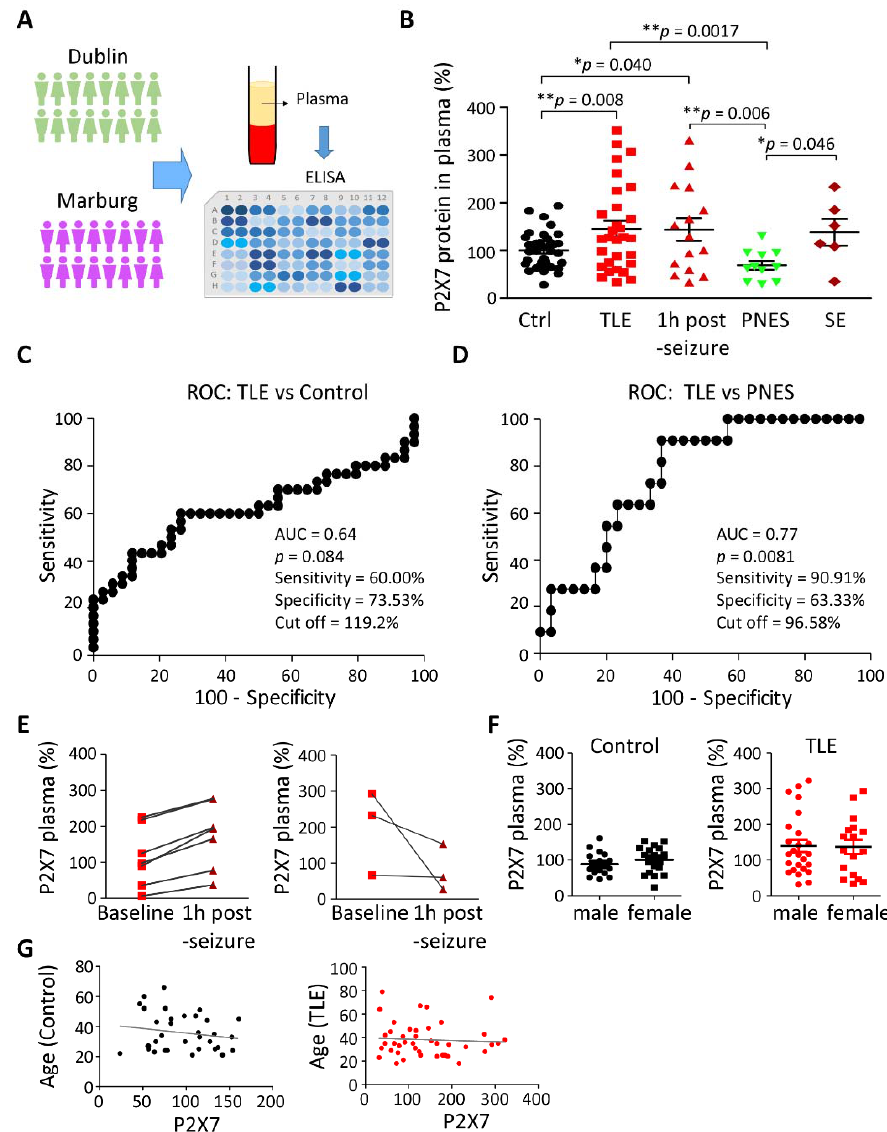
Figure 1. Increased P2X7R protein levels in plasma of patients with TLE. ( A ) Patients were recruited from two hospitals: Marburg Hospital (Germany) and Beaumont Hospital (Ireland), and plasma samples were analyzed via P2X7R-detecting ELISA. ( B ) Bar chart showing P2X7R protein levels in plasma from temporal lobe epilepsy (TLE) patients (N = 30) in baseline conditions and 1 h post ‐ seizure (N = 15) are higher when compared with healthy controls (Ctrl) (N = 34) and patients with psychogenic non ‐ epileptic seizures (PNES) (N = 11). In addition, P2X7R protein levels were also higher in patients suffering from an episode of status epilepticus (SE) (N = 6) when compared with PNES patients. ANOVA with post ‐ hoc Fisher correction. Data are given as percentage to control. ( C ) ROC curve analysis shows P2X7R plasma levels have a moderate sensitivity (60%) and good specificity (74%) for discriminating between healthy controls and TLE patients with an AUC of 0.64 at a cut ‐ off of 119.2%. ( D ) ROC curve analysis demonstrating a good sensitivity (90%) and specificity (63%) for discriminating between TLE patients and patients with PNES with an AUC of 0.77 at a cut ‐ off of 96.58%. ( E ) Dot plot showing P2X7R plasma levels in the same patients at baseline and 1 h post ‐ seizure. Out of 10 patients, 7 showed increased P2X7R in plasma and 3 lower P2X7R plasma levels 1 h post ‐ seizures when compared with the corresponding baseline levels. ( F , G ) No correlation of P2X7R plasma levels according to sex (F) (Control: p = 0.33; TLE: p = 0.92) or age ( G ) (Control: r 2 = 0.03 p = 0.33; TLE: r 2 = 0.003, p = 0.72). * p < 0.05, ** p < 0.01.